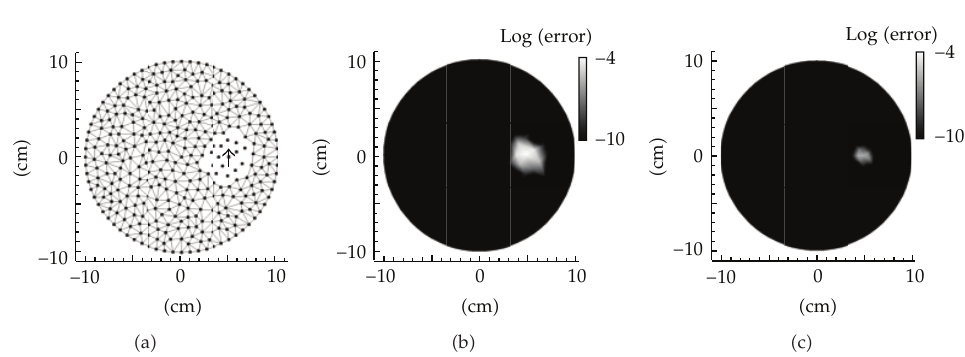
Figure 9: Test for EEG forward problem. (cid:2) a (cid:3) A dipole shown as an arrow is in the middle of FMLSRKM region, (cid:2) b (cid:3) result using FEM, and (cid:2) c (cid:3) result using the suggested hybrid method.